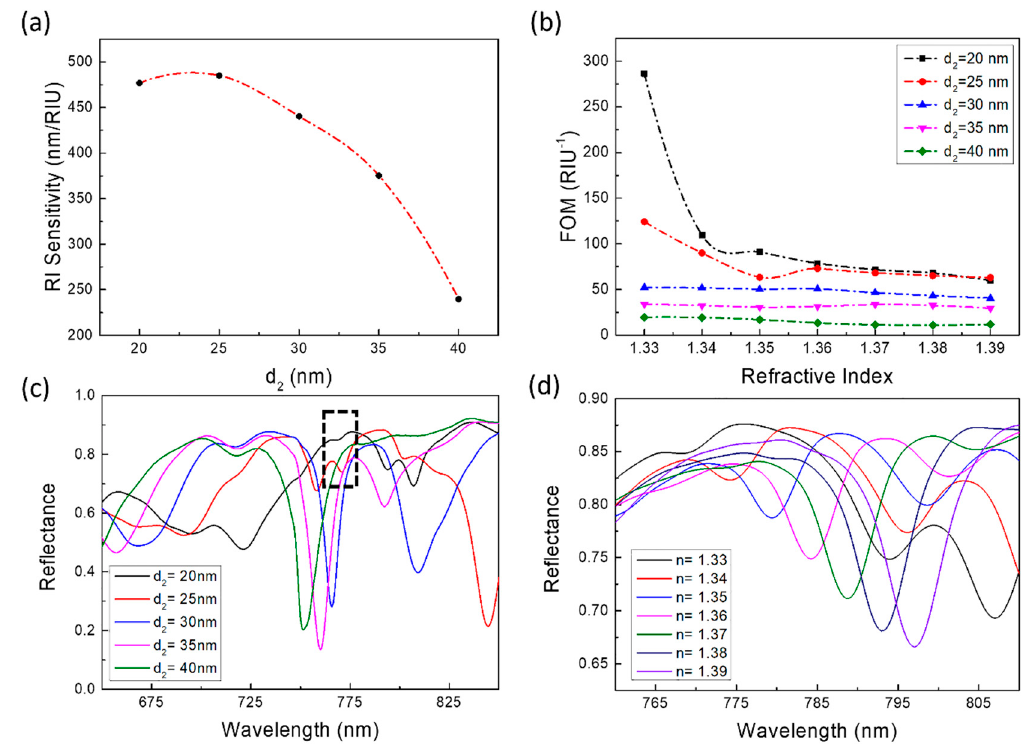
Figure 7. The performance influenced by d 2 . ( a ) The sensitivity changes with d 2 . ( b ) The impact of d 2 changes on FOM, when n = 1.33–1.39. (The dashed line connecting the data points is simply connected with a smooth curve for readers as a guide for an eye.) ( c ) When n = 1.33, the reflection spectrum of the structure changes with d 2 . Mode 2 is in the range of 750– 775 nm. (d) When d 2 = 20 nm, the reflection spectrum of the structure changes with refractive index (RI).